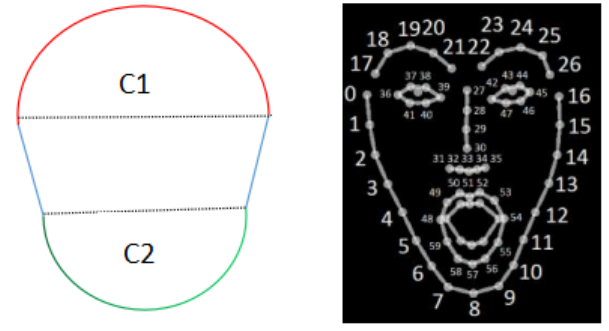
Figure 8. Face contour model and Openpose keypoints.